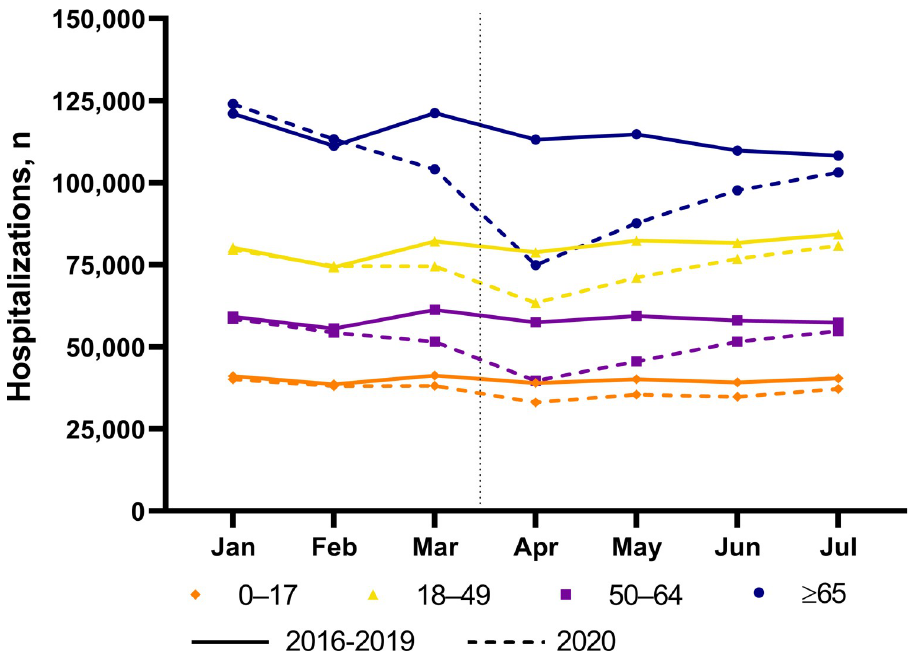
Fig 4. Average monthly all-cause hospitalizations, January-July, in 2016–2019 compared with monthly all-cause hospitalizations in 2020, by age group, United States. Vertical black dotted line, when stay-at-home orders began (mid-March 2020). COVID-19 = coronavirus disease